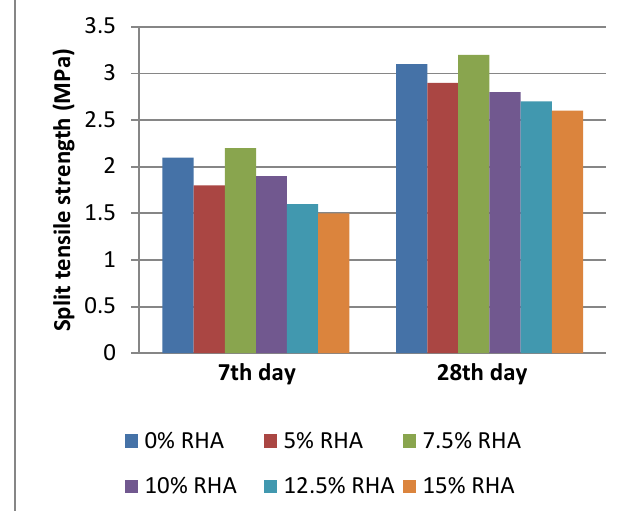
Table 8: Split tensile strength of cylinder